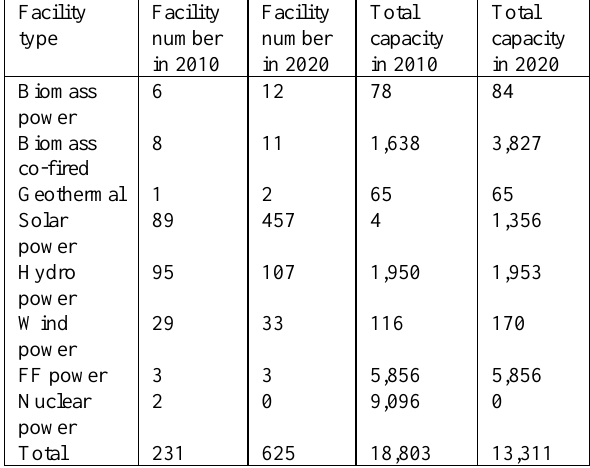
Table 1. The condition of the electricity supply facilities in 2010